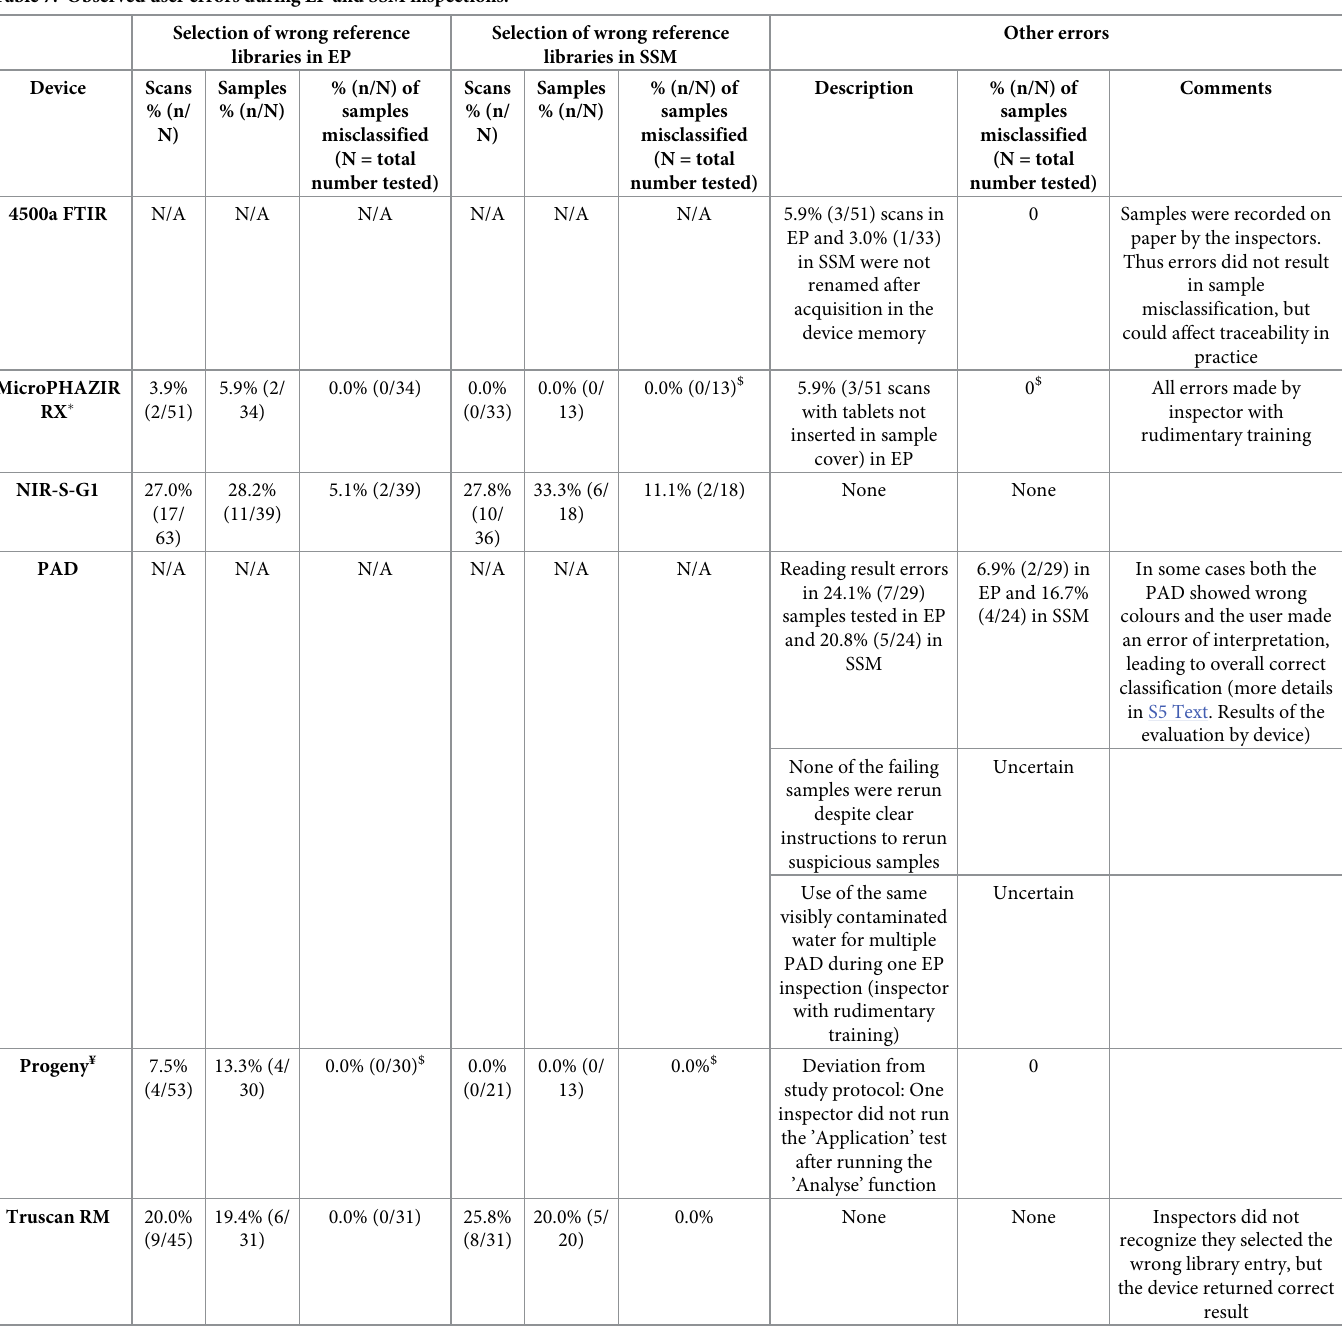
Table 7. Observed user errors during EP and SSM